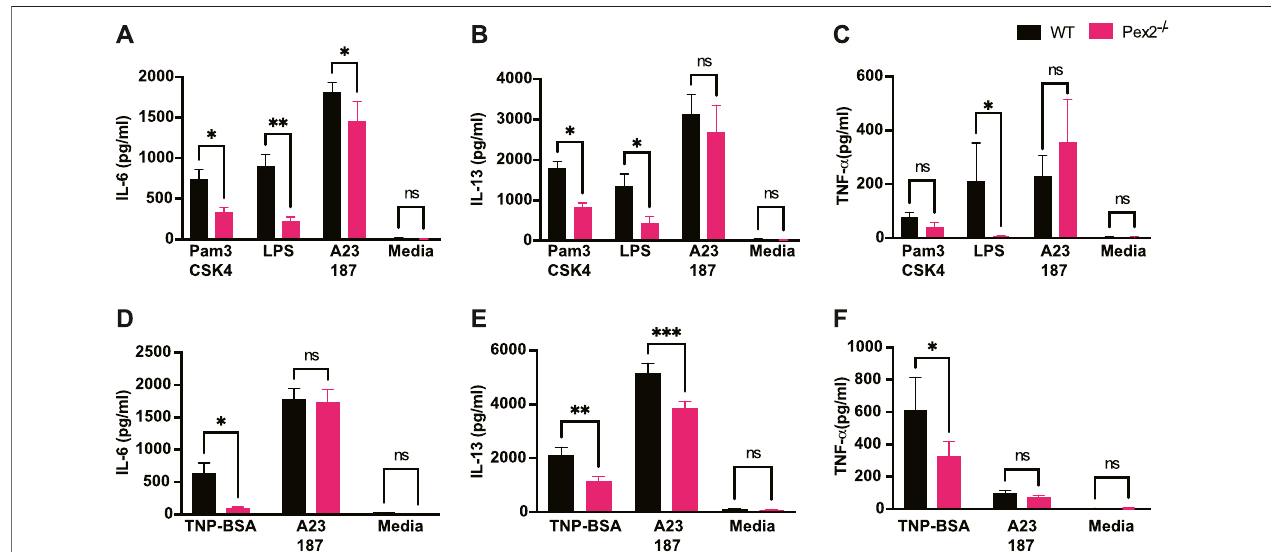
FIGURE 2 | Absence of peroxisome leads to decreased MCs cytokine release upon TLRs and IgE-mediated activation: WT and Pex2 − / − BMMCs were treated with TLRs agonist or TNP-BSA for 24 h and cytokines amounts were measured by ELISA. (A) IL-6, (B) IL-13 and (C) TNF- α production after TLR2 agonist Pam3CSK4, TLR4agonistLPSand calciumionophoreA23187treatments. (D – F) Samereadouts weremeasured afterIgEcrosslinkingwithTNP-BSAtreatmentfor24 h.Themedia columns in each graph represent the baseline level detected for each cytokine. The graphs represent the average of three independent experiments ±SEM. Statistical analyses were performed using a non-parametric t-test comparing between Pex2 − / − and WT BMMCs. * p < 0.05, ** p < 0.001, ns: not signi fi